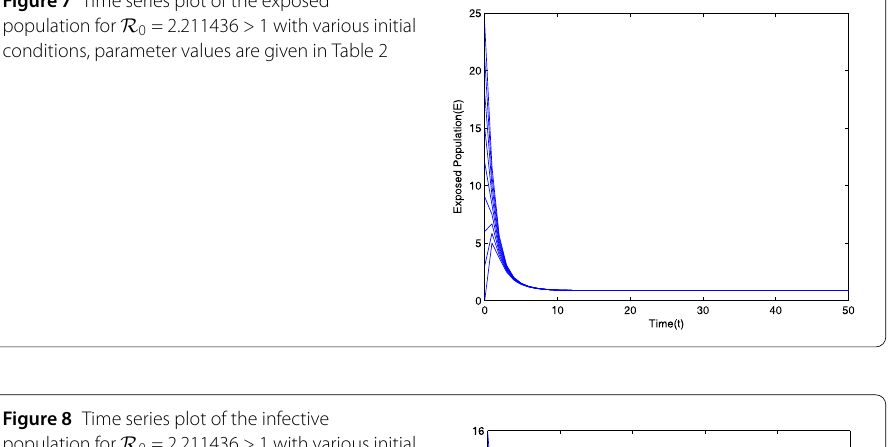
Figure 8 Time series plot of the infective population for R 0 = 2.211436 > 1 with various initial conditions, parameter values are given in Table 2